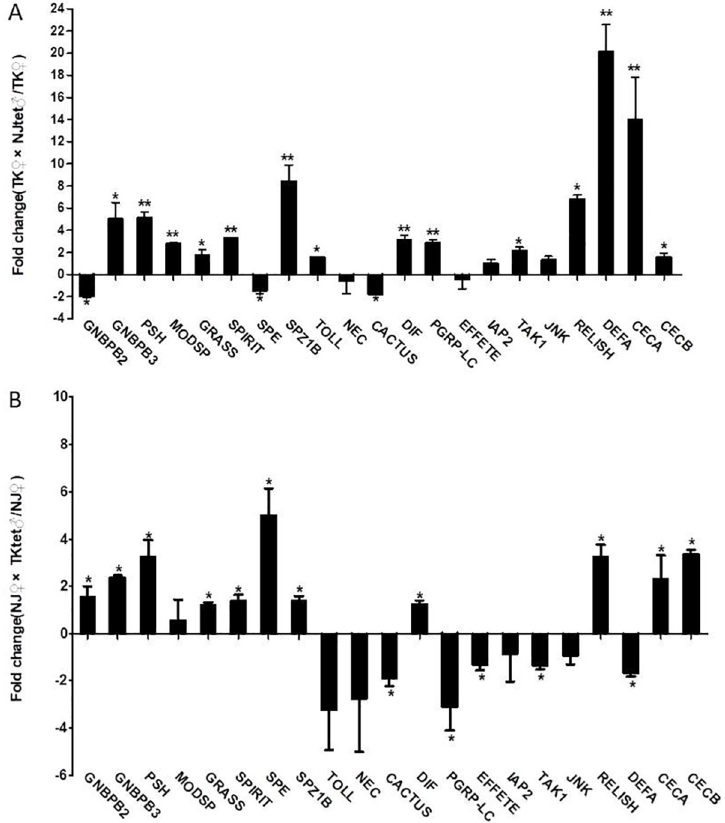
Fig 4. Survival curves of the mosquitoes post-challenge with M. luteus (a, c) or E. coli (b, d). For each mosquito population, three parallel groups of 15-20 adult females each were inoculated per bacterial species. A total of three biological replicates of the infection experiment were performed. Error bars indicate the standard error. Survival curves are significantly different between mosquitoes in old and new host- Wolbachia symbioses (compared using log- rank